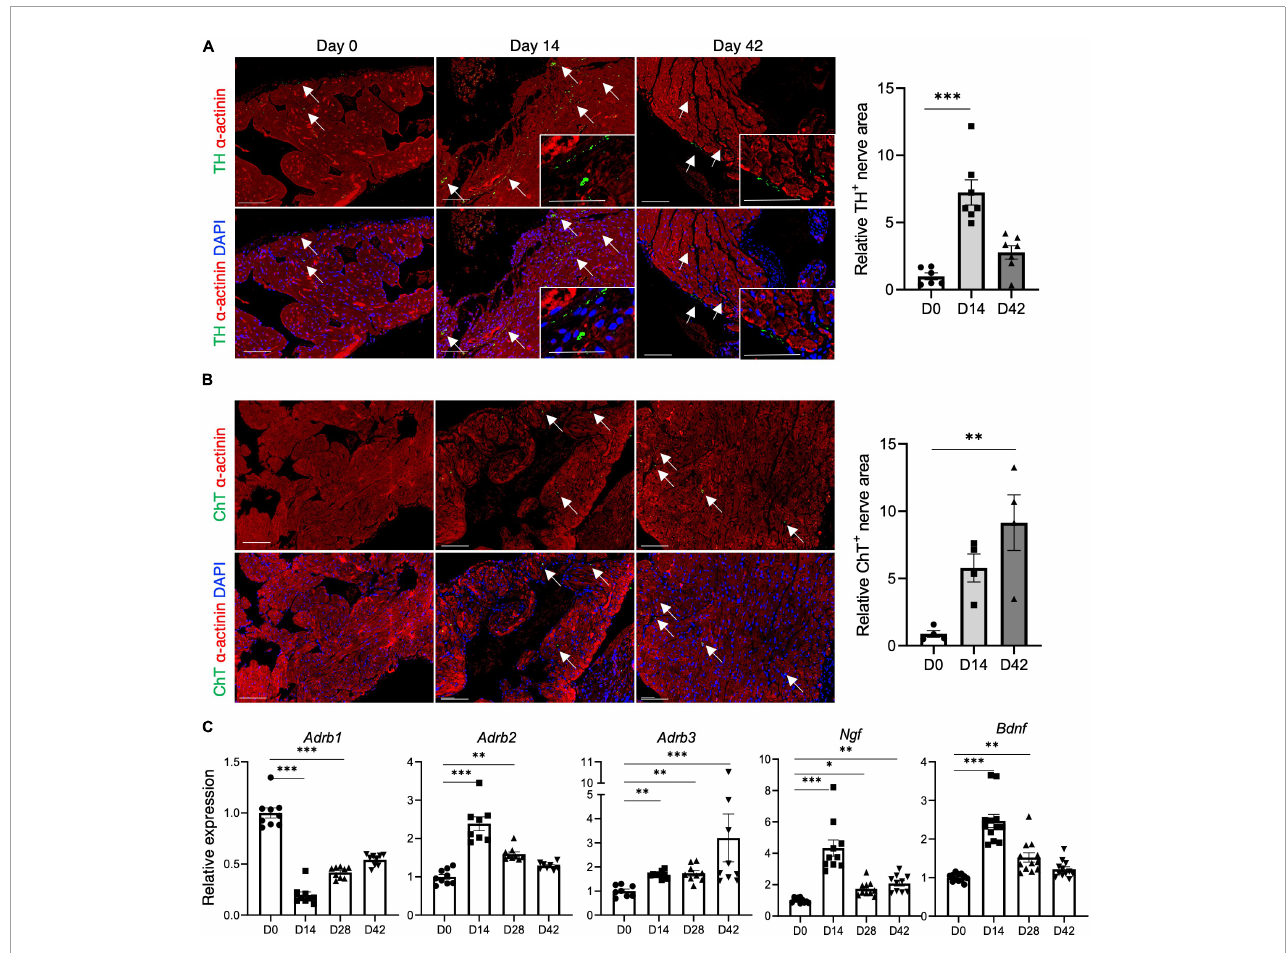
FIGURE4 Autonomic remodeling in inflammatory atrial cardiomyopathy. (A,B) Immunostaining for TH (A) and ChT (B) in the atrium. Nerve areas (indicated by arrows) immunopositive for TH and ChT were determined using ImageJ software. The bar graphs show the relative TH + or ChT + nerve area when D0 was set to 1. Scale bars = 50 µ m (C) qRT-PCR analysis of autonomic remodeling-related genes. ∗ P < 0.05, ∗∗ P < 0.01, ∗∗∗ P < 0.001 using the Kruskal–Wallis test with Dunn’s test. TH, anti-tyrosine hydroxylase; ChT, anti-choline transporter; qRT-PCR, quantitative reverse transcription polymerase chain reaction.